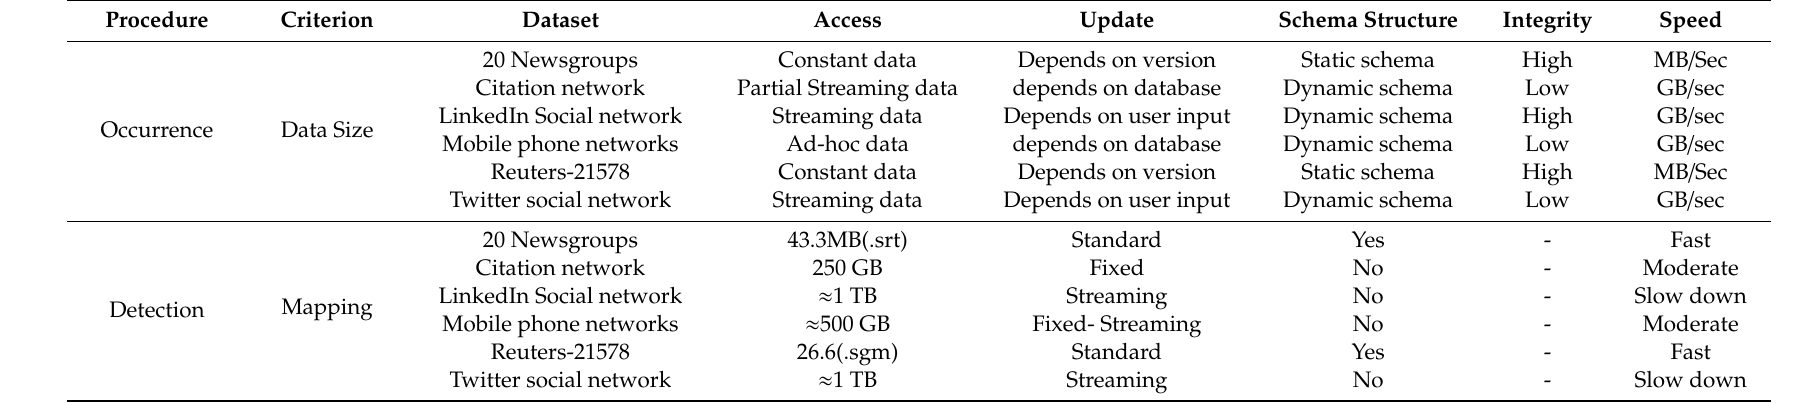
Table 4. Occurrence and detection rate for each dataset